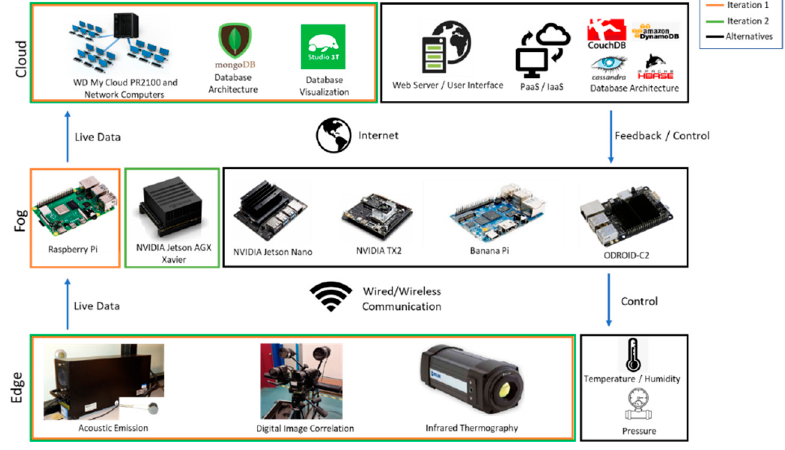
Figure 1. Hardware and software architecture in the developed Industrial Internet of Things (IIoT)